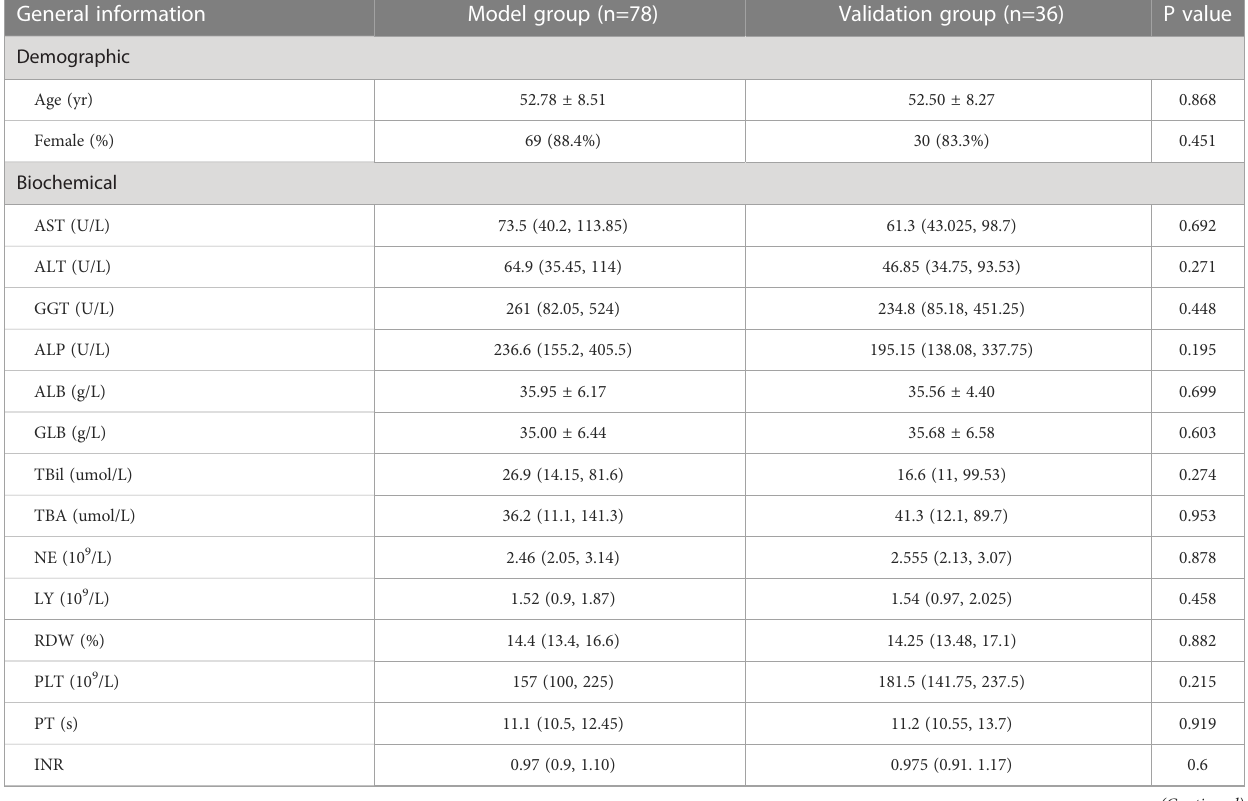
TABLE 1 General information of model group and validation